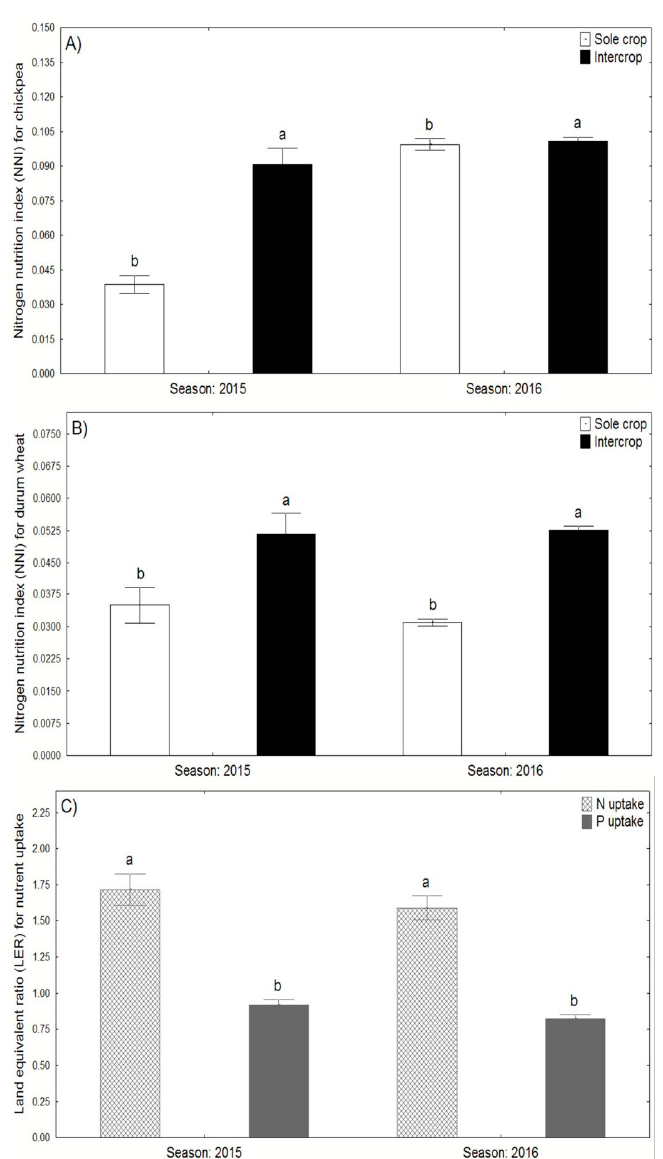
Figure 5. Nitrogen nutrition index (NNI) for chickpea ( A ) and durum wheat ( B ) as sole crops and intercrops, and LER ( C ) for N and P uptake in 2015 and 2016. Values represent the average of 10 replicates ± SE (standard errors). p -values from ANOVA (cropping system, season, and cropping system × season). Bars with the different letters compare cropping systems and years within a crop and are significantly different at p < 0.05.